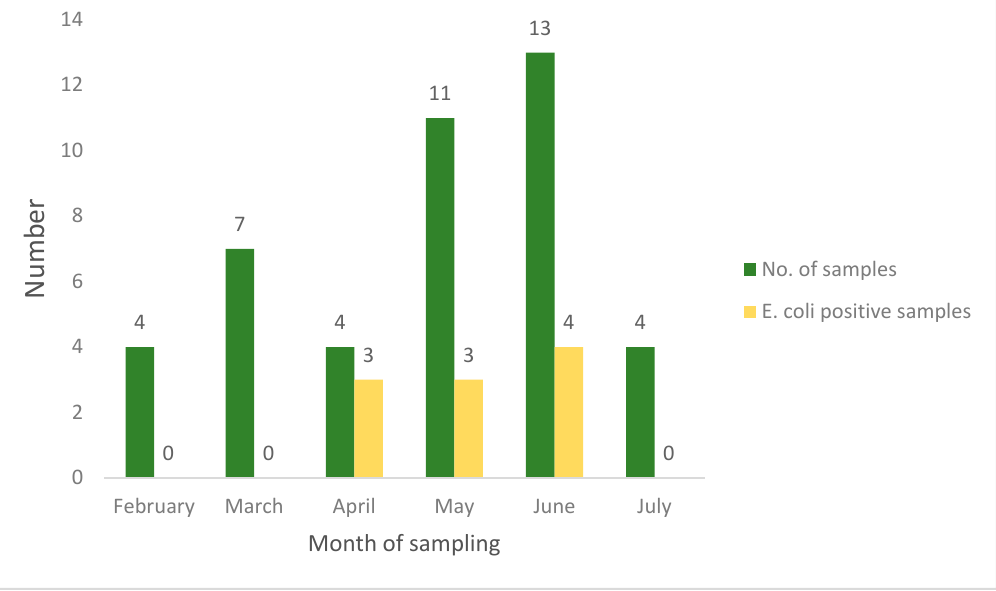
Figure 2. Month-wise distribution of E. coli in liver samples from layers.